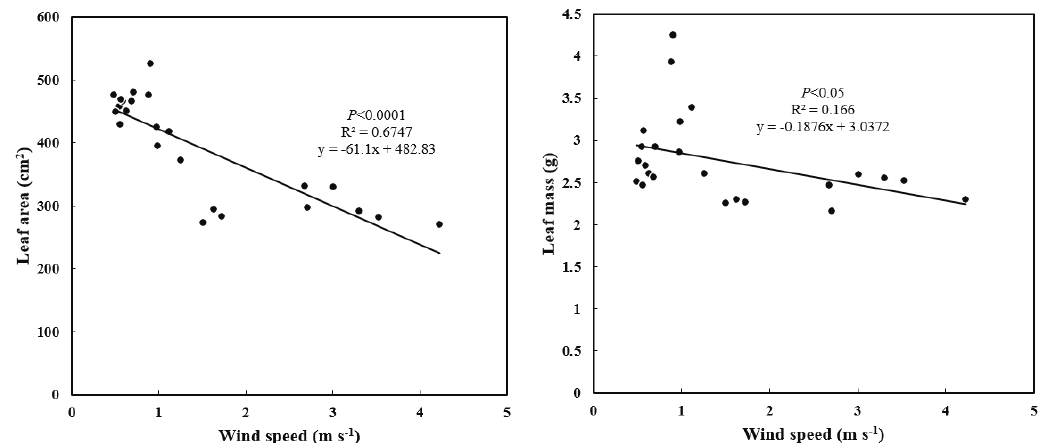
Figure A2. The relationships between leaf area, mass and wind speed for P. thunbergii along the coast- inland gradient.